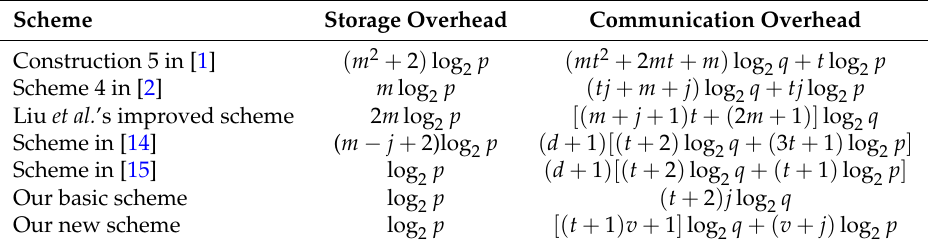
Table 3. Comparison of storage